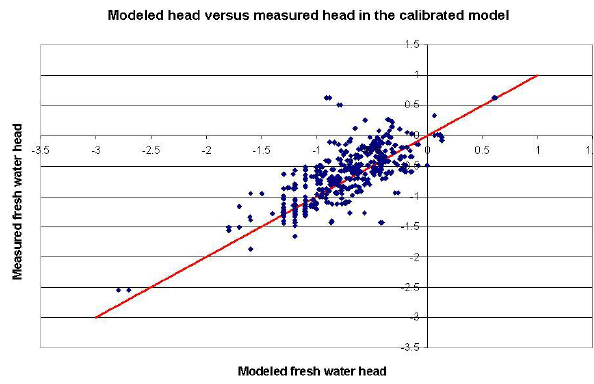
Fig. 14. Plot showing the modelled fresh water heads versus the Figure 14 Plot showing the modelled fresh water heads versus the measured fresh water heads. measured fresh water